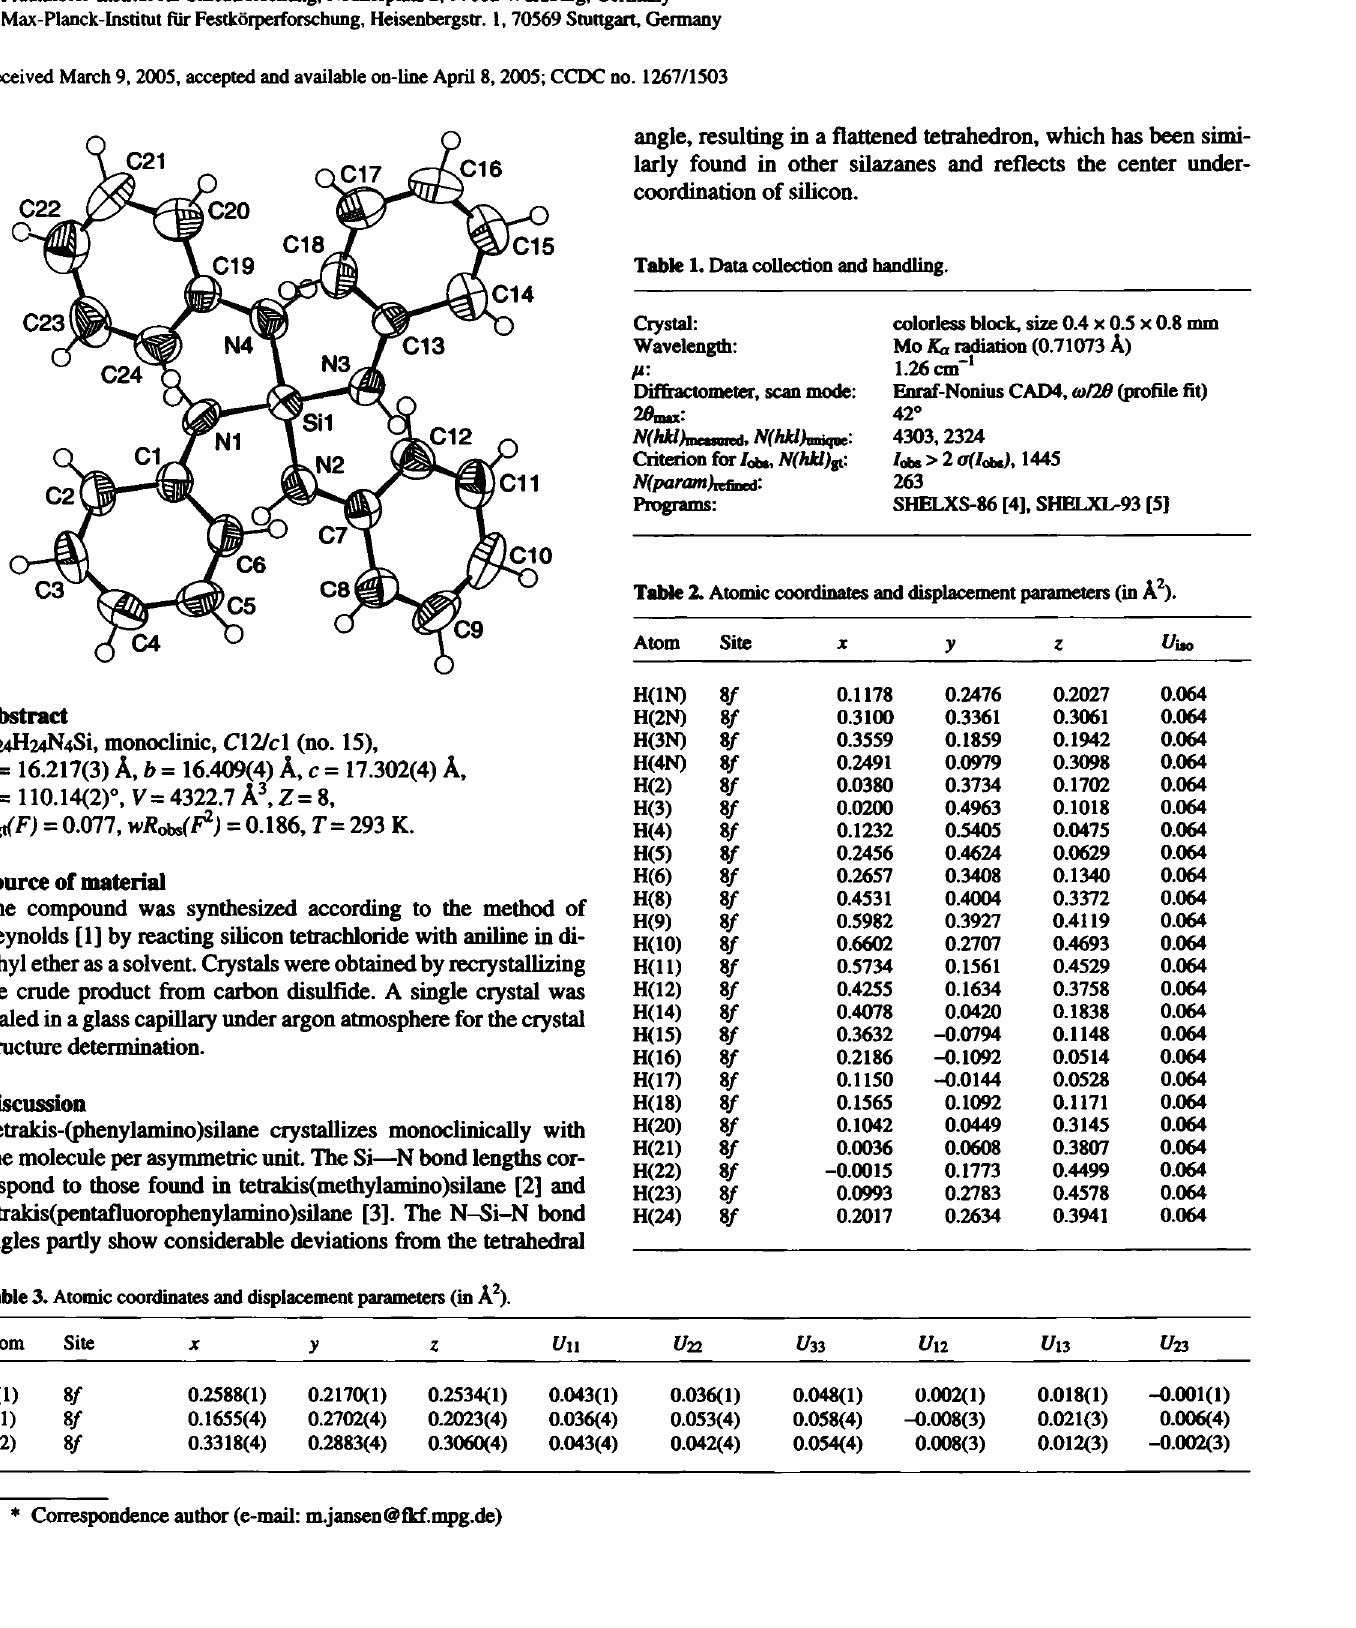
Table 1. Data collection and handling. Crystal: Wavelength: